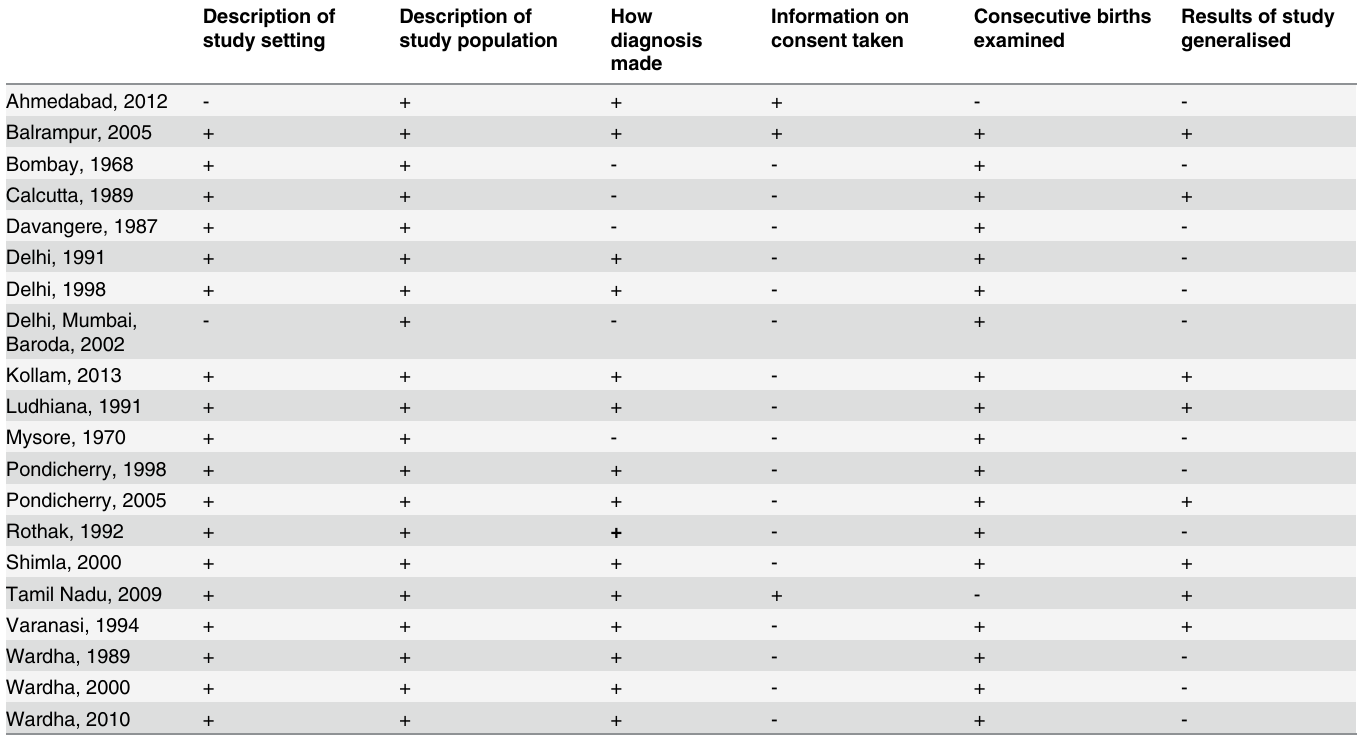
Table 2. Quality Assessment of Individual studies based on the STROBE